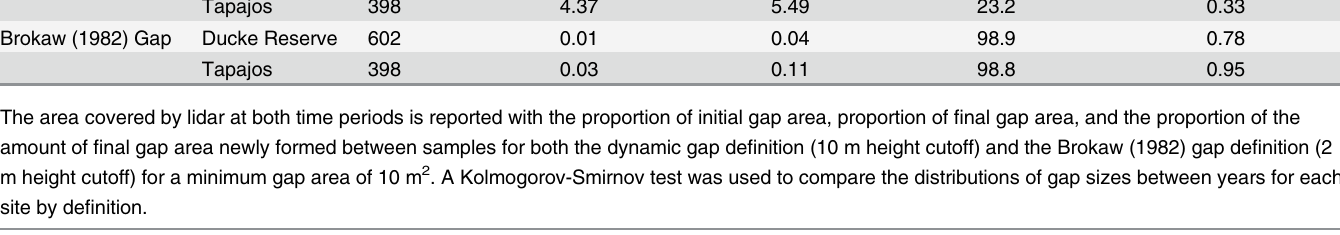
Table 2. Frequency of gap formation presented for both sites and gap definitions.